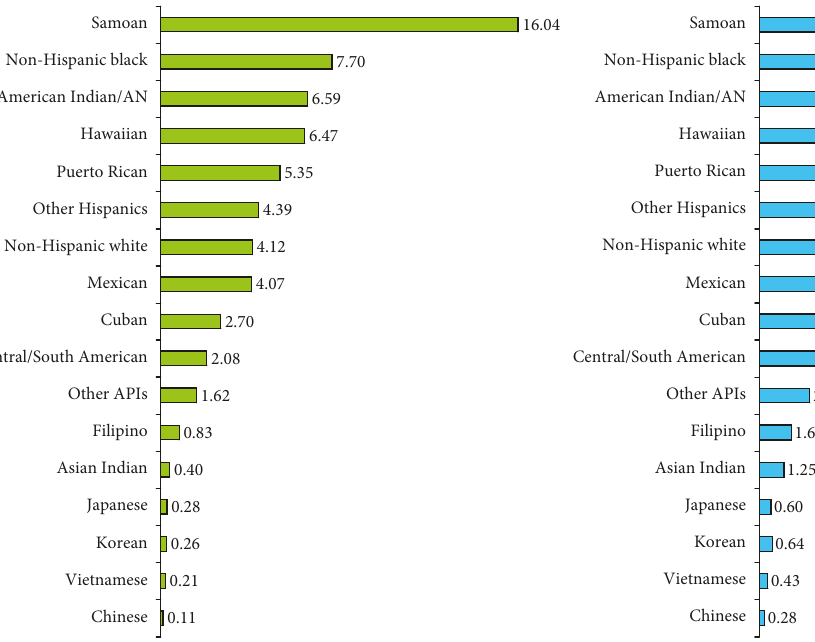
Figure 1: Racial/ethnic disparities in observed and adjusted 1 prevalence (%) of severe pre-pregnancy obesity (BMI ≥ 40) among US women, 2012–2014. 1 Adjusted for maternal age, parity, marital status, nativity/immigrant status, maternal education, and place and region of residence. Table 3: Racial/ethnic variation in selected sociodemographic risk factors for pre-pregnancy overweight or obesity among women, United States, 2012–2014 ( N � 10 , 431 ,